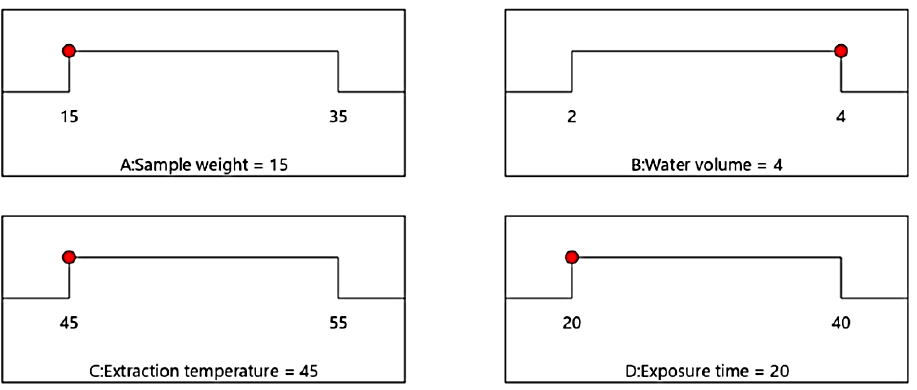
Figure 4. Optimized conditions for the isolation of safranal by SPME proposed by the model using the desirability function.